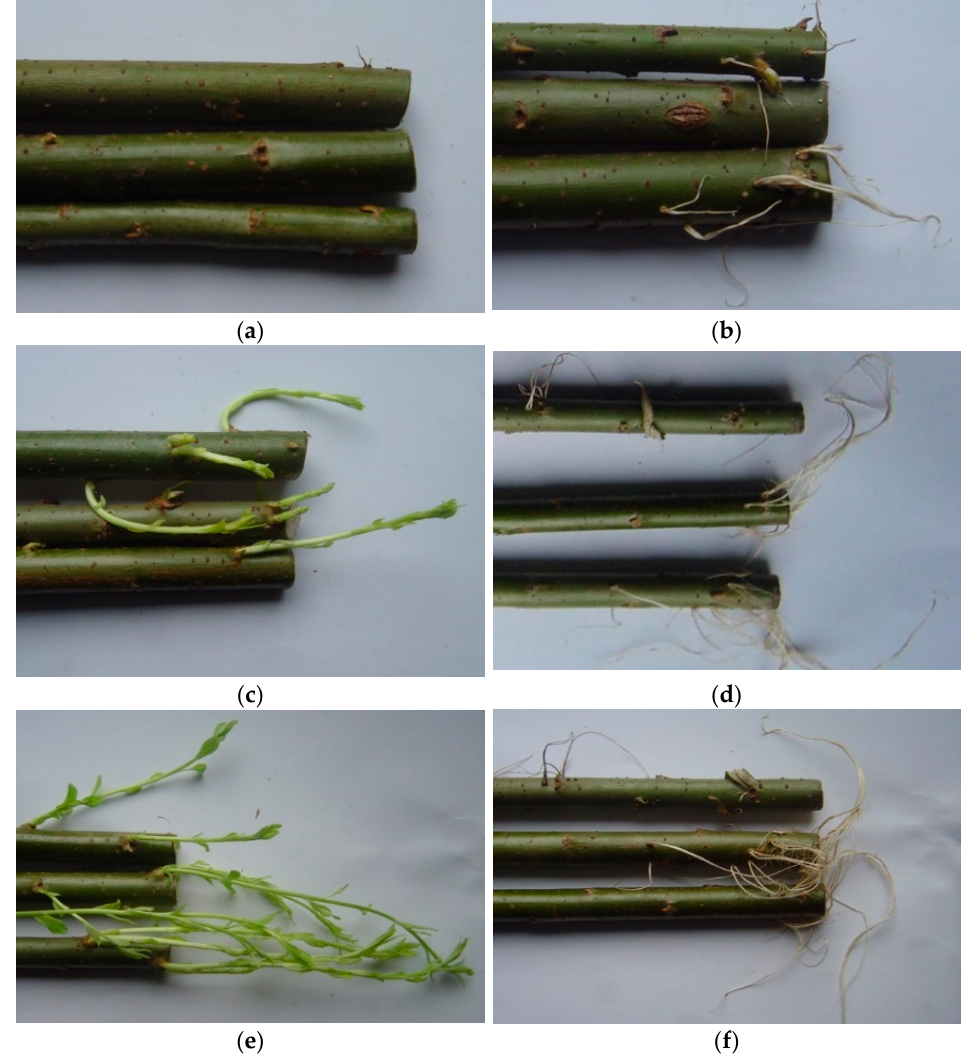
Figure 2. Cultivation: shoots: ( a ) 1 week, ( c ) 2 weeks, ( e ) 3 weeks; Root system: ( b ) 1 week, ( d ) 2 weeks, ( f ) 3 weeks.